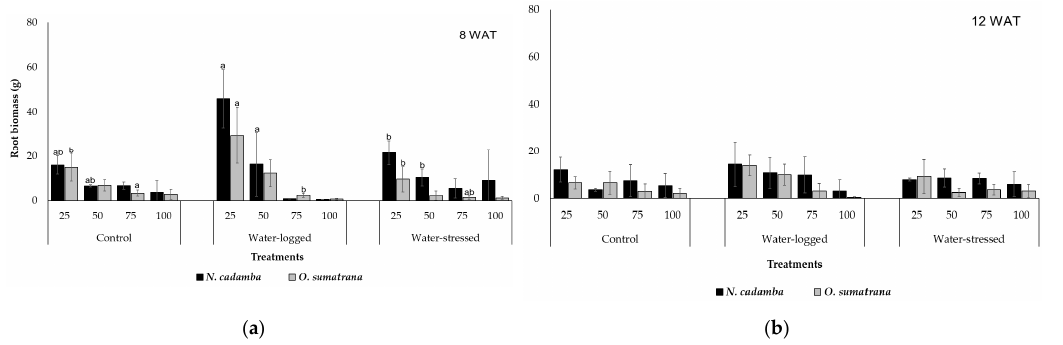
Figure 5. ( a ) Root biomass (g) at 8 WAT under water-stress, water-logged, and control treatment for N. cadamba and O. sumatrana at different soil depths. A two-way ANOVA test was used, followed by Tukey’s HSD ( p < 0.05, n = 3). Error bars indicate standard deviation. Different letters indicate a significant difference between the various conditions for each depth tested. ( b ) Root biomass (g) at 12 WAT under water-stress, water-logged, and control treatment for N. cadamba and O. sumatrana at different soil depths. A two-way ANOVA test was used, followed by Tukey’s HSD ( p > 0.05, n = 3). Error bars indicate standard deviation.